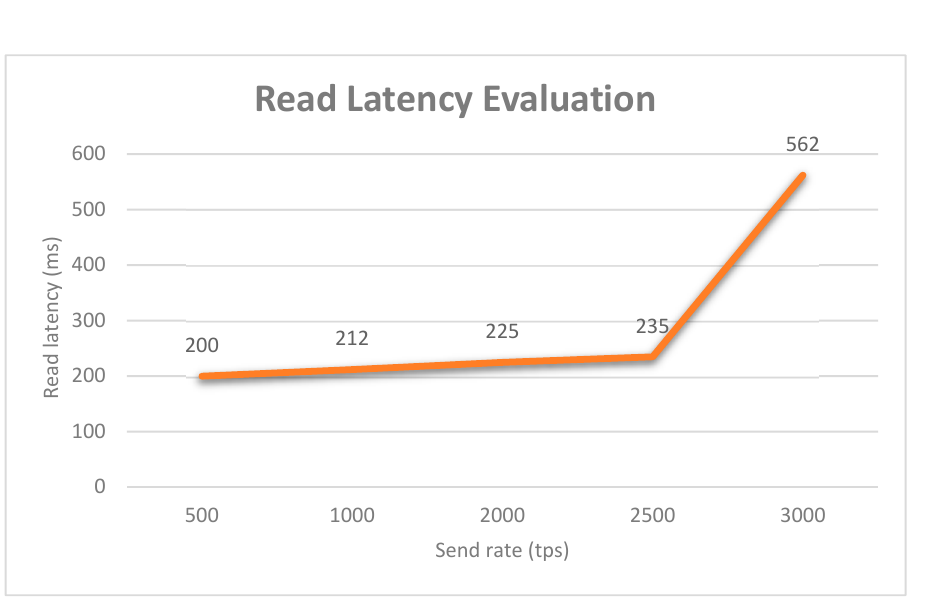
Figure 22. Blockchain network read latency evaluation.